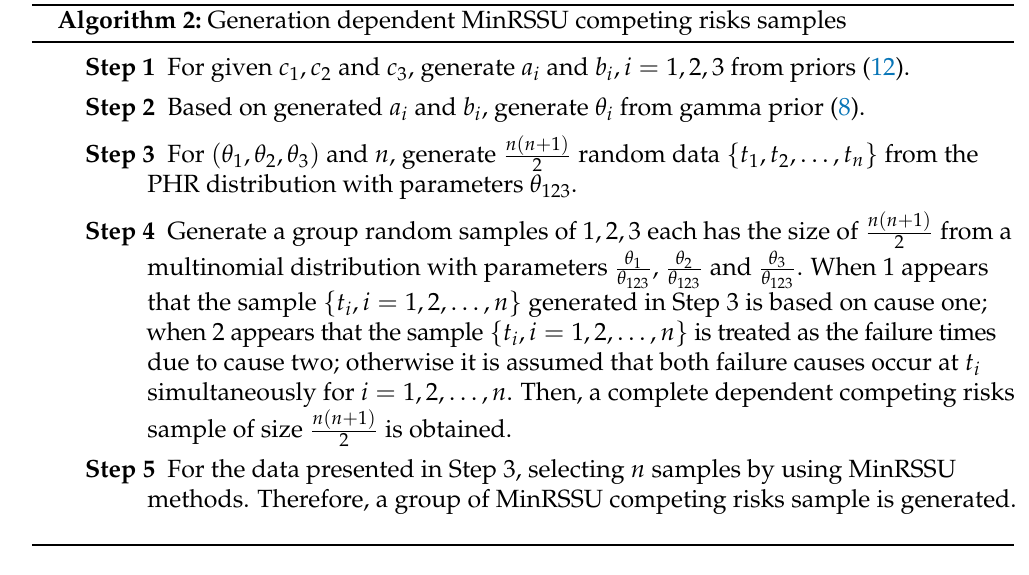
Algorithm 2: Generation dependent MinRSSU competing risks